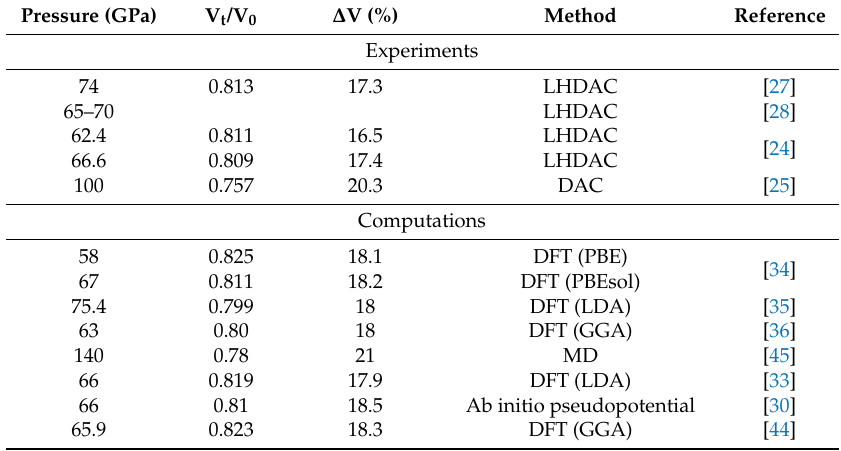
Table 1. Parameters for the transition from zinc-blende (B3) to rocksalt (B1) SiC, compiled from both experiments and computations. V t /V 0 represents the ratio of the volume of B3 SiC at the transition, to the zero pressure volume of B3. ∆ V (%) shows the change in volume between B3 and B1 at the transition